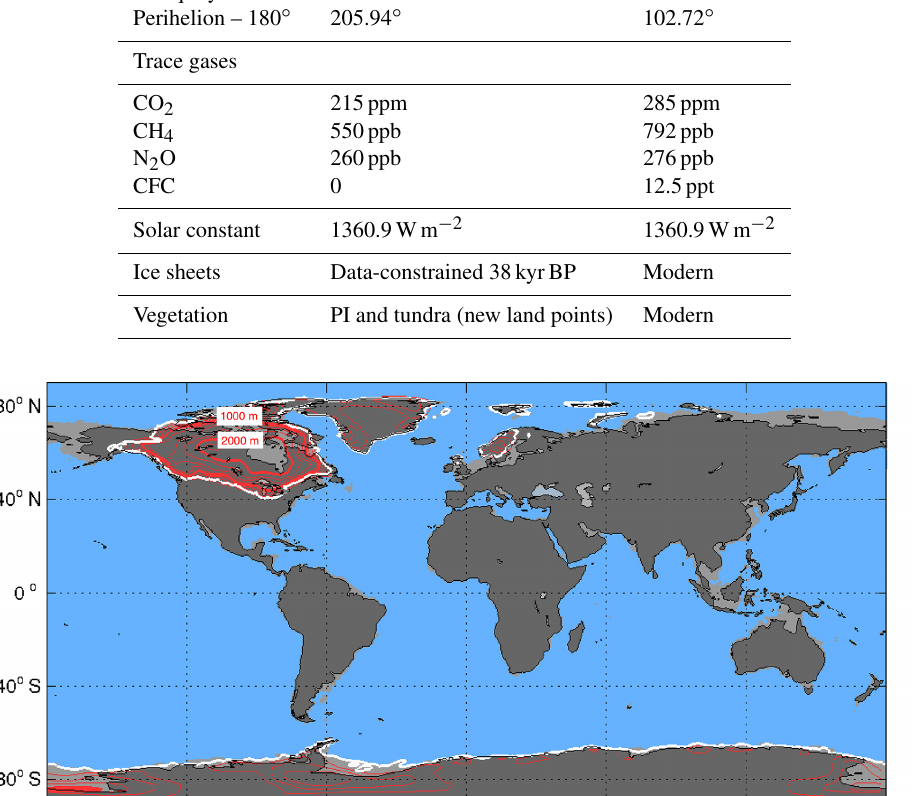
Figure 2. Land–sea mask (light grey/blue shading; dark grey indicates modern land), ice sheet extent (white line) for the MIS3 experiment, and the difference of ice sheet orography relative to PI (red contours with an interval of 250m; the 1000 and 2000m isolines are highlighted with bold red